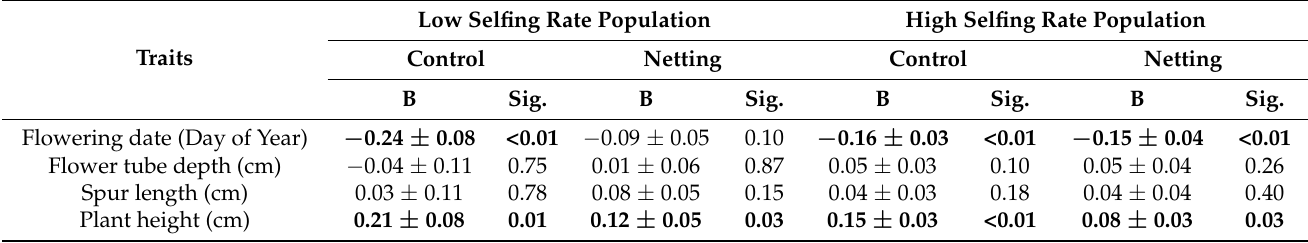
Table 4. Phenotypic linear selection gradients ( ± SE) for the flowering date, flower tube depth, spur length, and plant height via female fitness in netted and natural control flowers from two Halenia elliptica populations with different selfing rates. Significant phenotypic linear selec- tion gradients are shown in